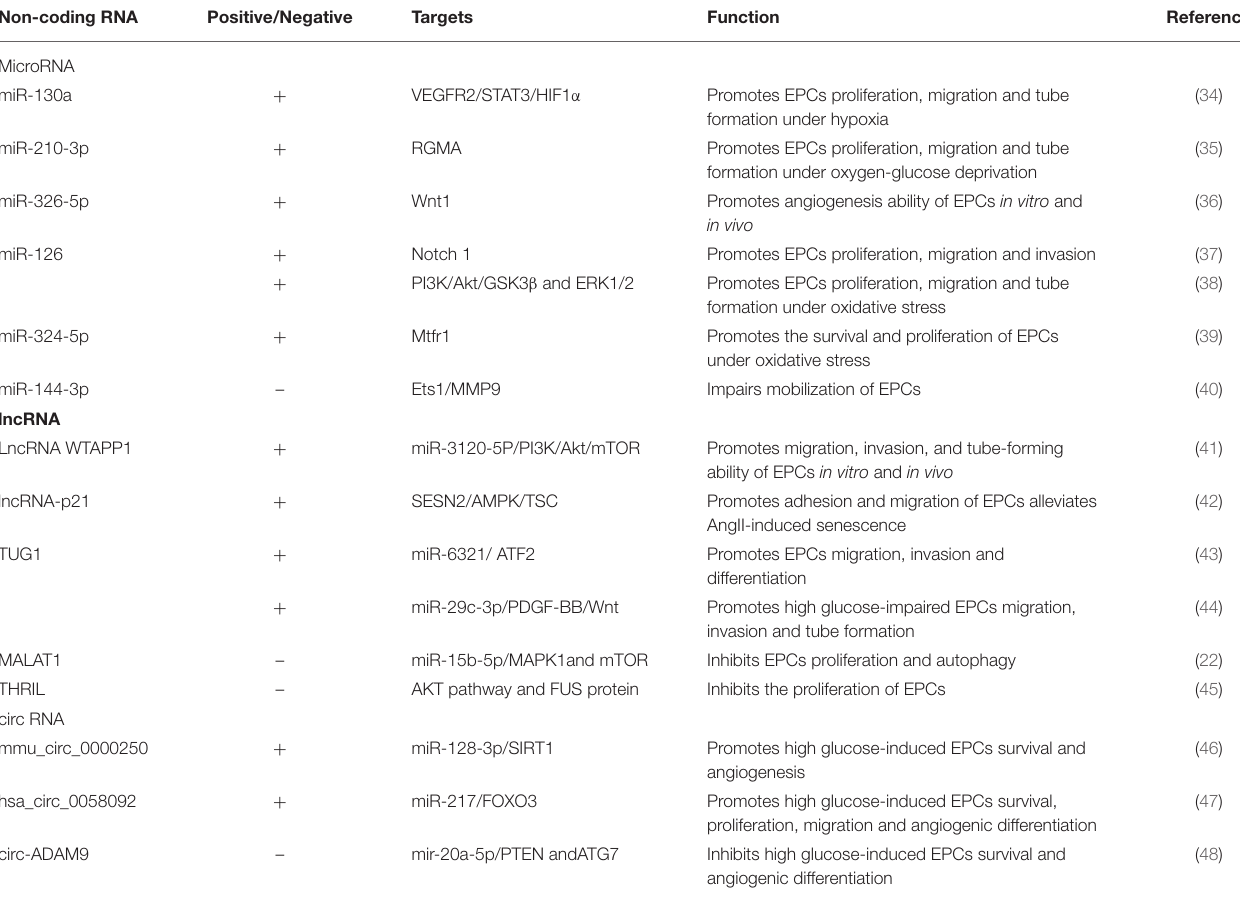
TABLE 1 | Non-coding RNAs regulate EPCs